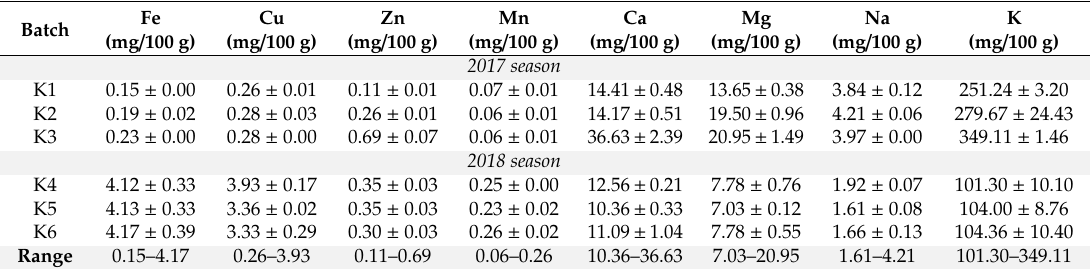
Table 6. Mineral content (mg / 100g fw) of deastringed persimmon fruits (‘Rojo Brillante’ variety) analysed in 2017 and 2018 seasons. Results expressed as mean ± standard deviation ( n –1), n =